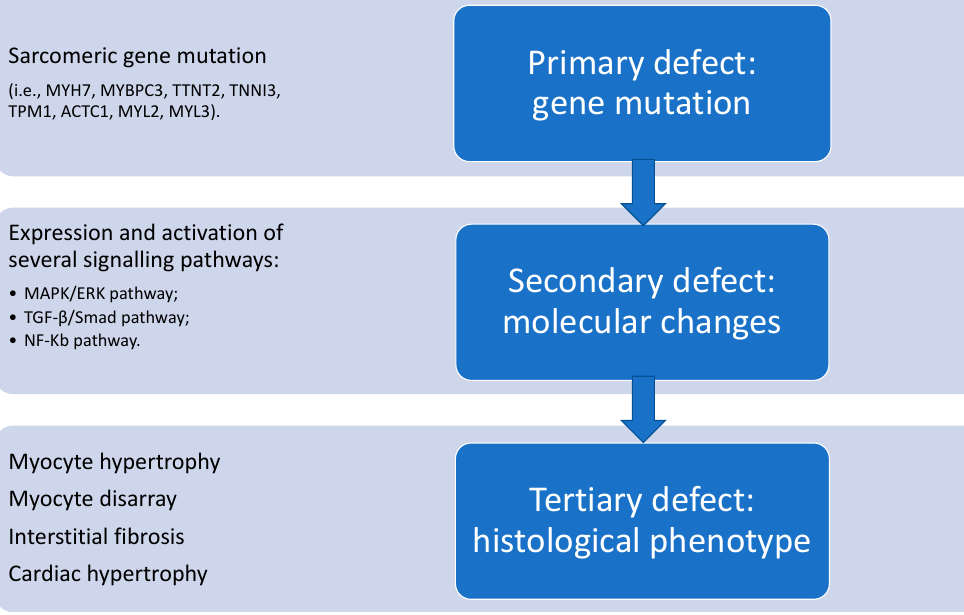
Figure 3. Schematic representation of the pathogenesis of hypertrophic cardiomyopathy. See text for